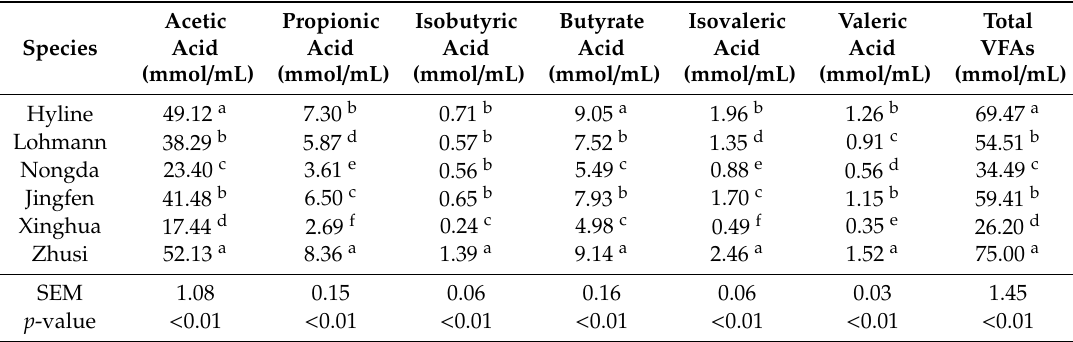
Table 3. The volatile fatty acid (VFA) concentrations in six species of laying hens ( n =